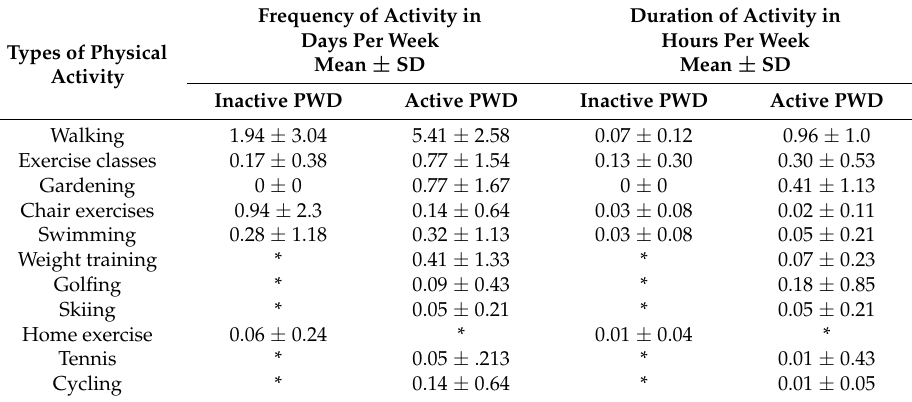
Table 2. Frequency and duration of physical activities performed by